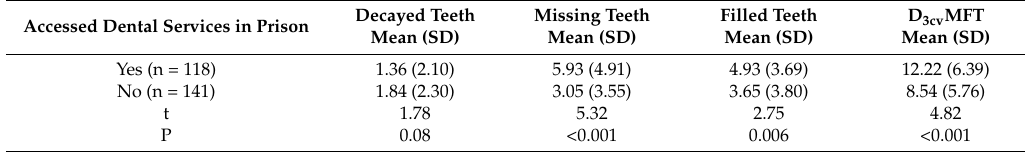
Table 2. Mean score of D 3cv MFT, decayed, missing, and filled teeth in this Scottish prisoner population. Accessed Dental Services in